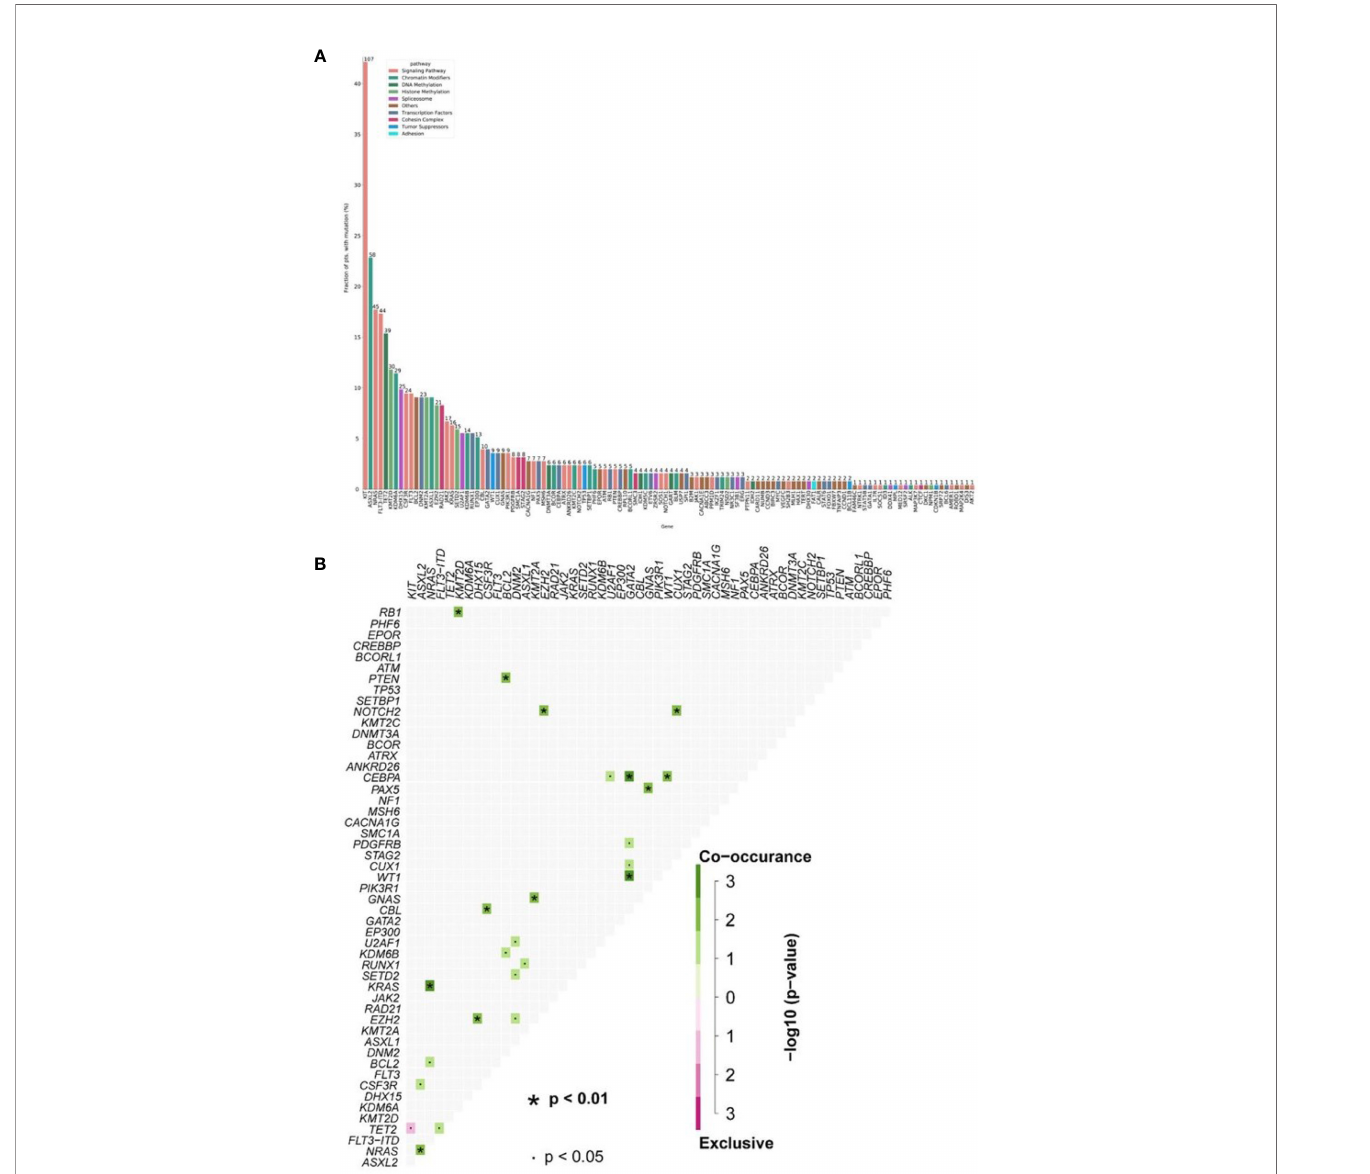
FIGURE 1 | (A) Mutational landscape in 254 AML1-ETO patients. (B) The number of gene mutations per patient. (Each row represents stated gene; each column represents a patient; the right side of the graph annotates the frequency and number of the gene; the upper histogram showed the number of gene mutations per patient; different colors below the graph represent different mutation